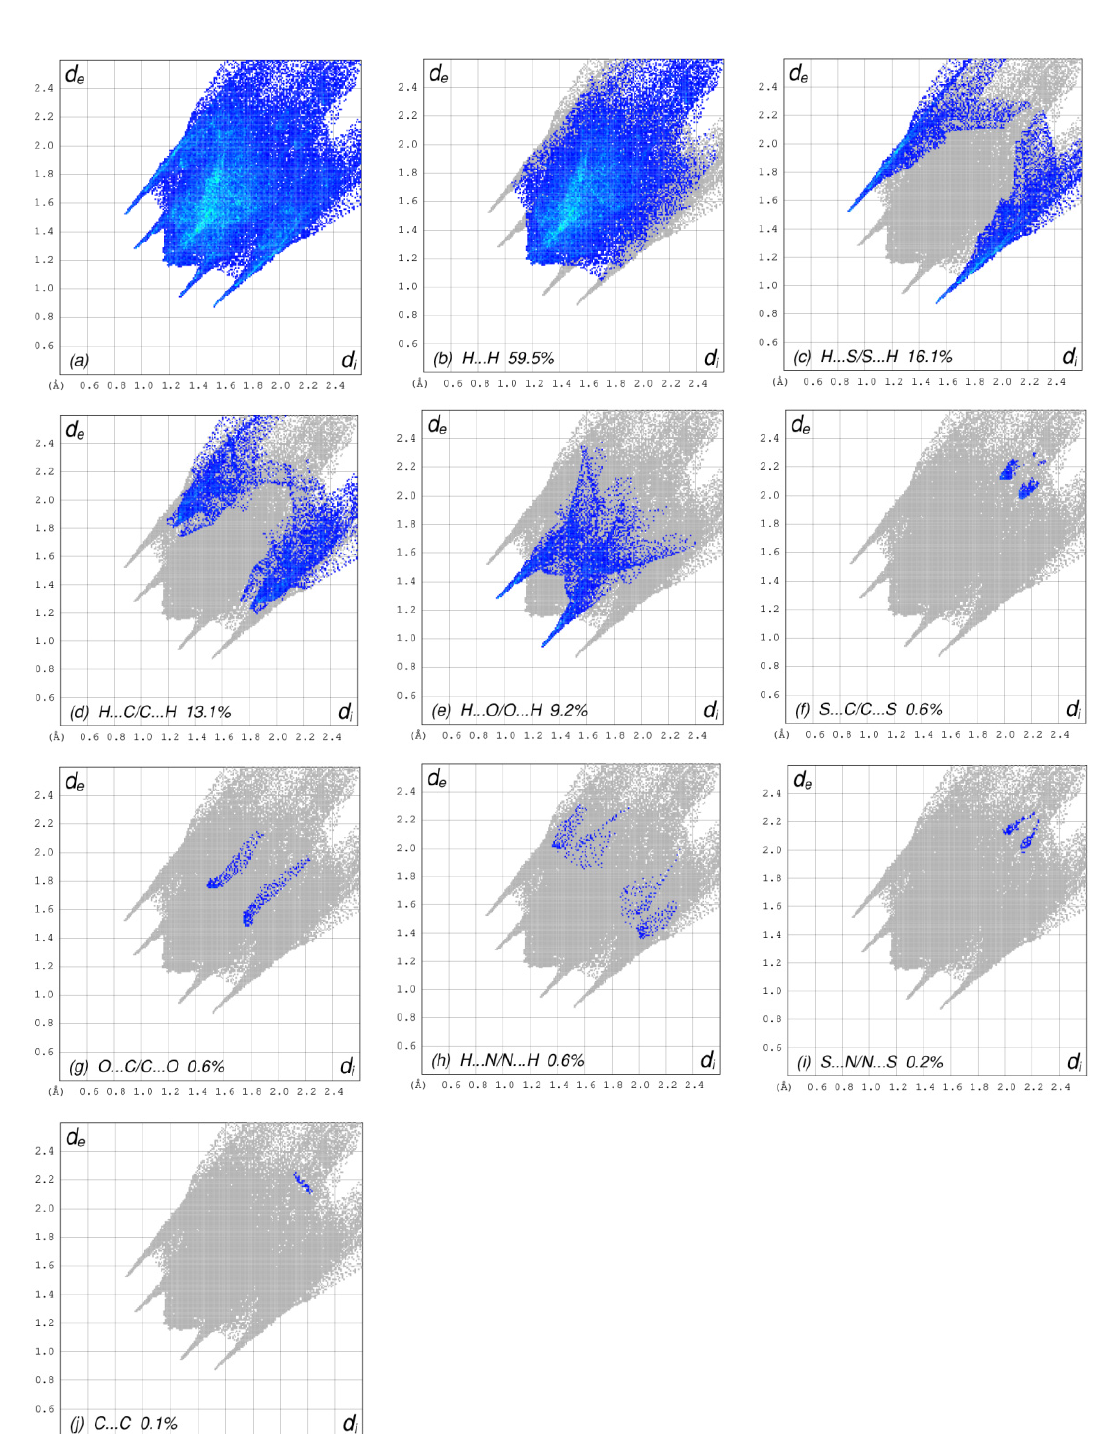
Figure 5. The complete 2D fingerprint plots showing compound 4 ( a ) all interactions, and delineated into ( b ) H · · · H, ( c ) H · · · S/S · · · H, ( d ) H · · · C/C · · · H, ( e ) H · · · O/O · · · H, ( f ) S · · · C/C · · · S, ( g ) O · · · C/C · · · O/, ( h ) H · · · N/N · · · H, ( i ) S · · · N/N · · · S, ( j ) C · · · C interactions.